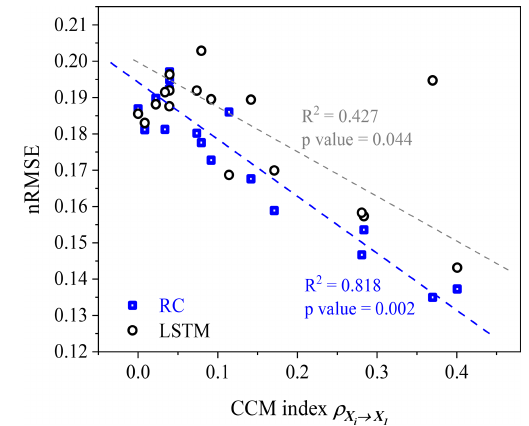
Figure 8. Scatter plot of nRMSE values and the CCM index val- ues. Blue and gray dashed lines are the fitted linear trends for the scatters.